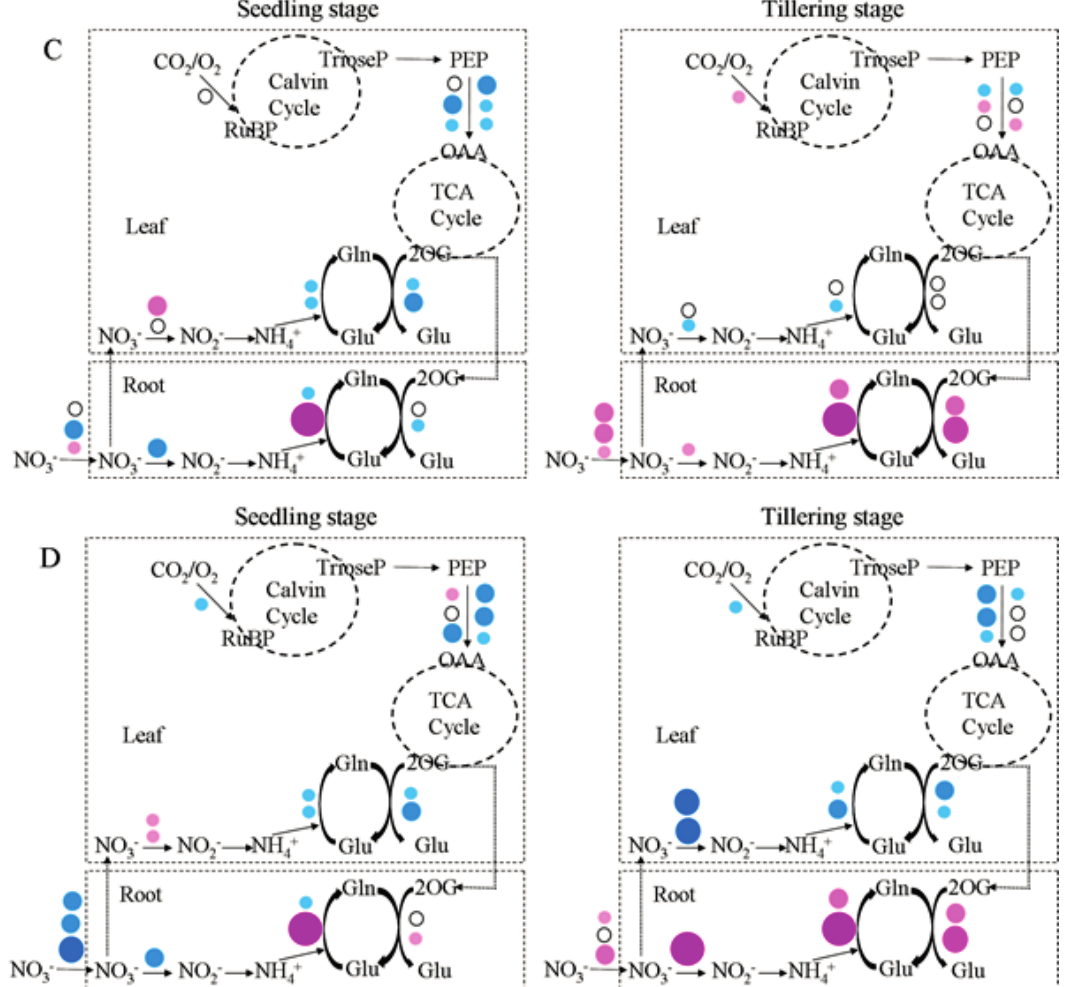
Figure 6. The fold change corresponds to the ratio of the gene expression level in the GS2 -cosuppressed plants relative to the wild-type plants. ( A ) Diagrammatic representation of the key genes involved in the carbon and nitrogen metabolic pathway in rice plants. NRT, nitrate transporter; NR, nitrate reductase; GS, glutamine synthetase; GOGAT, glutamate synthase; RUBISCO, ribulose-1,5-bisphosphate carboxylase/oxygenase; PEPC, phosphoenolpyruvate carboxylase. Prominent changes in the gene expression level in the stage under N ( B ), G ( C ) and N + G ( D ) conditions. Red and blue dots indicate up- and down-regulated genes,